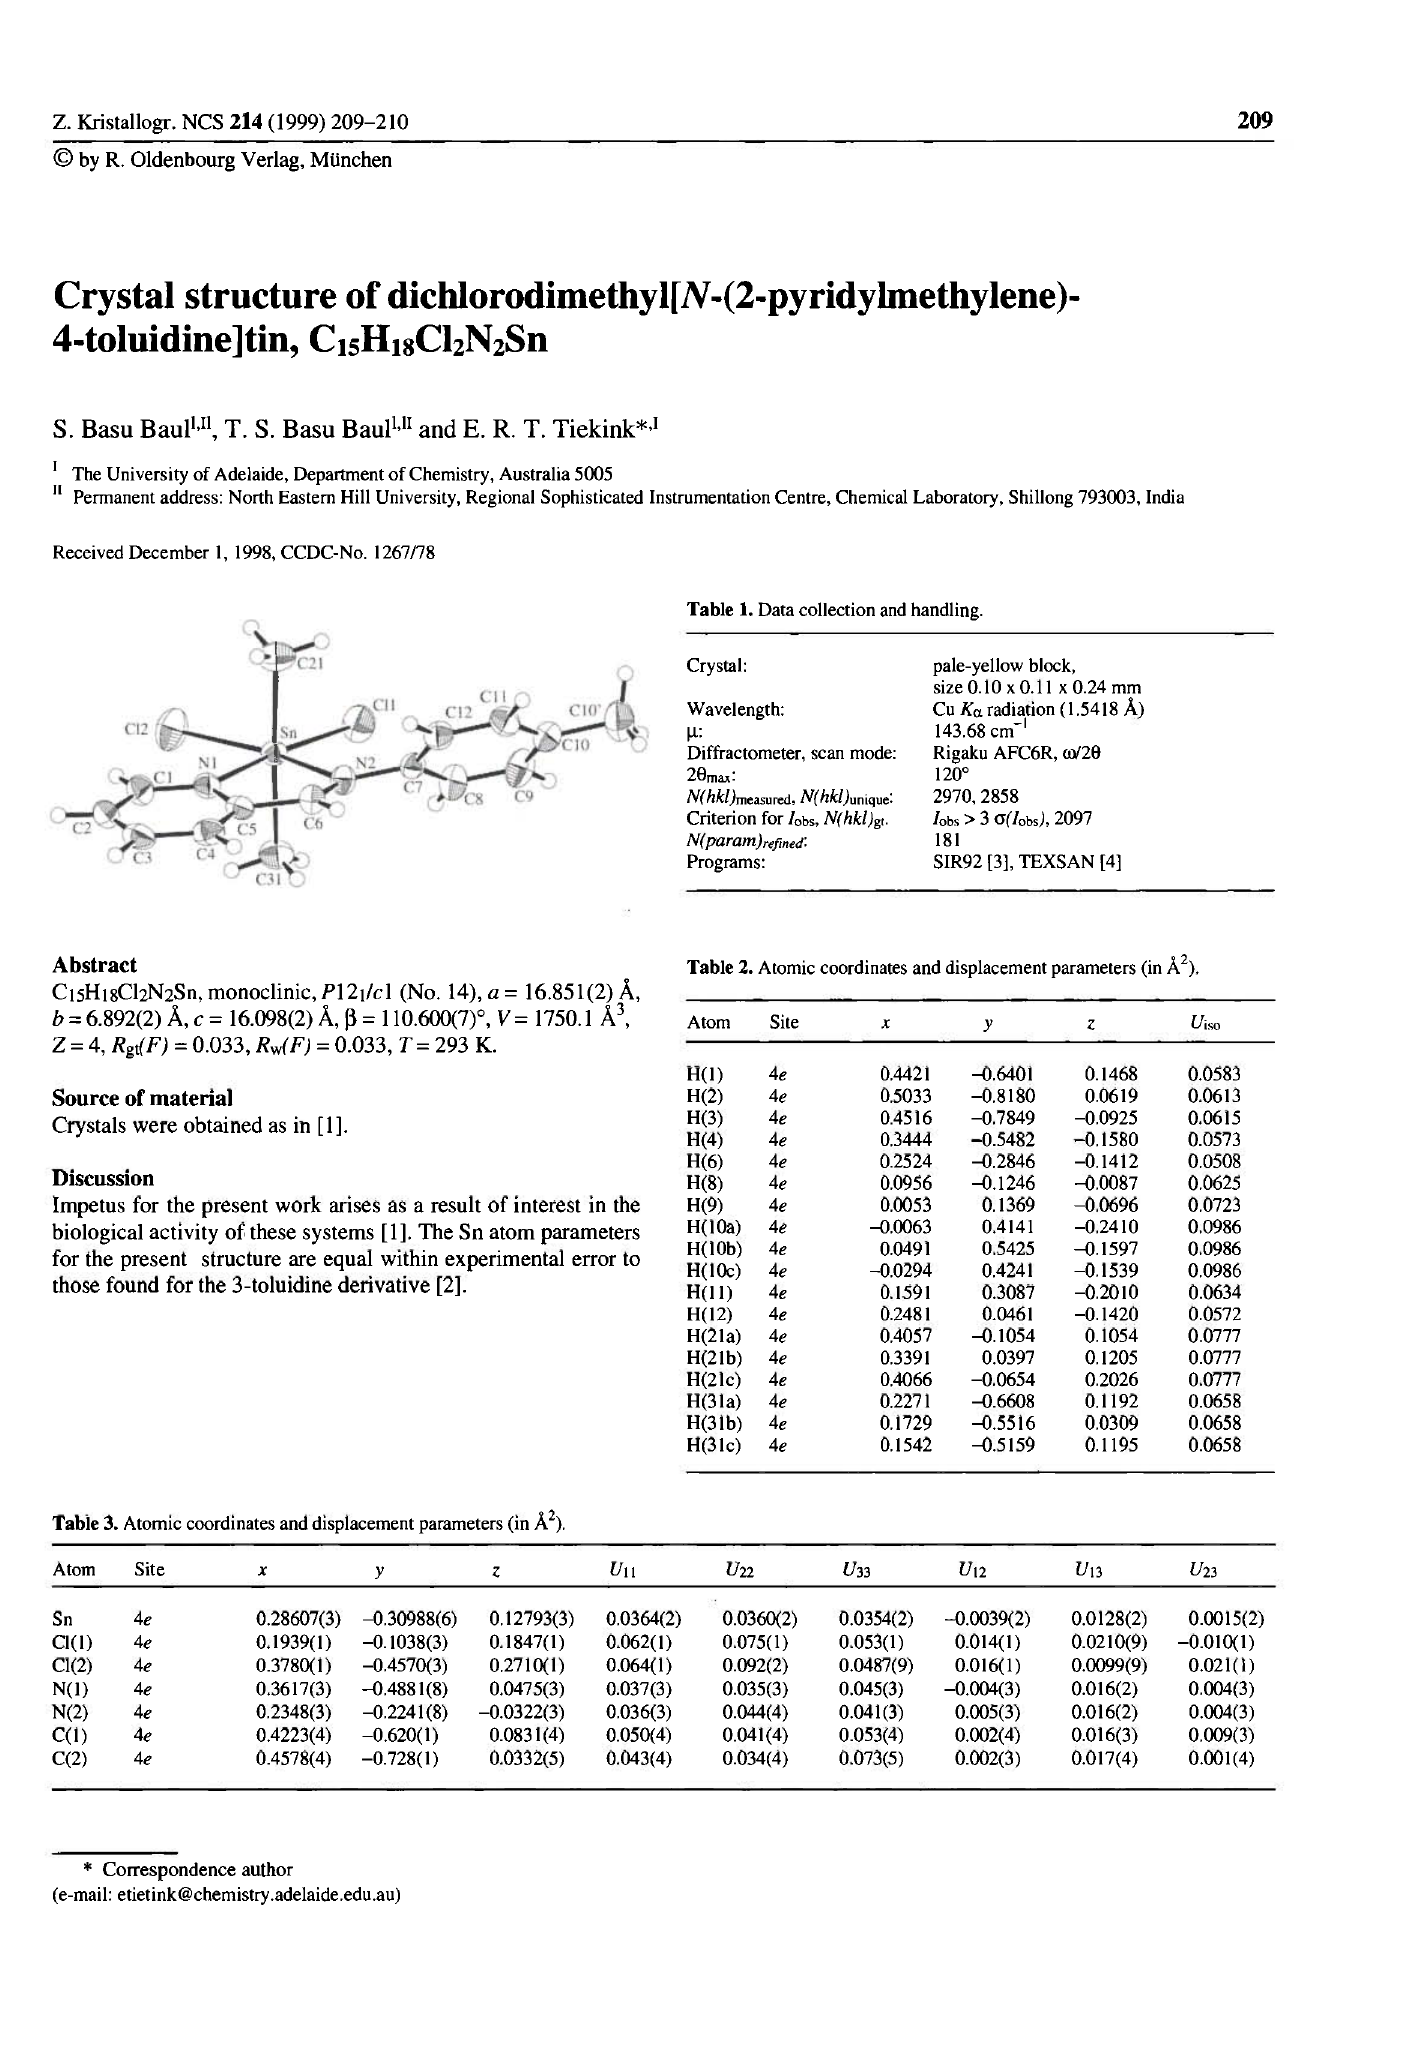
Table 3. Atomic coordinates and displacement parameters (in Ä 2